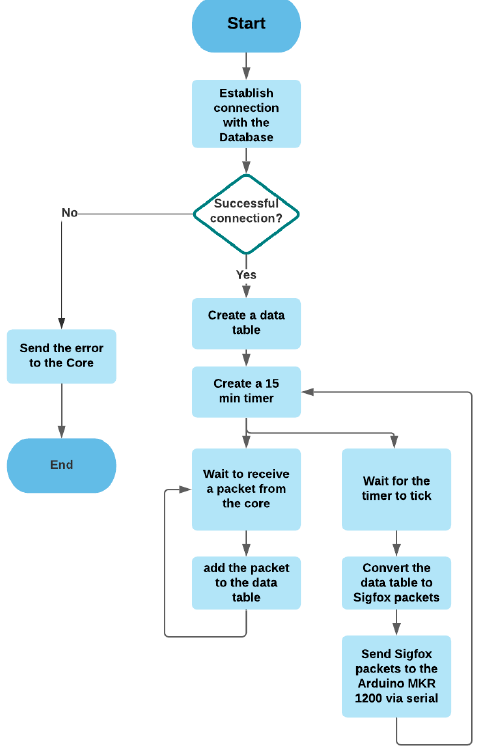
Figure 19. The flowchart of the Sigfox module.